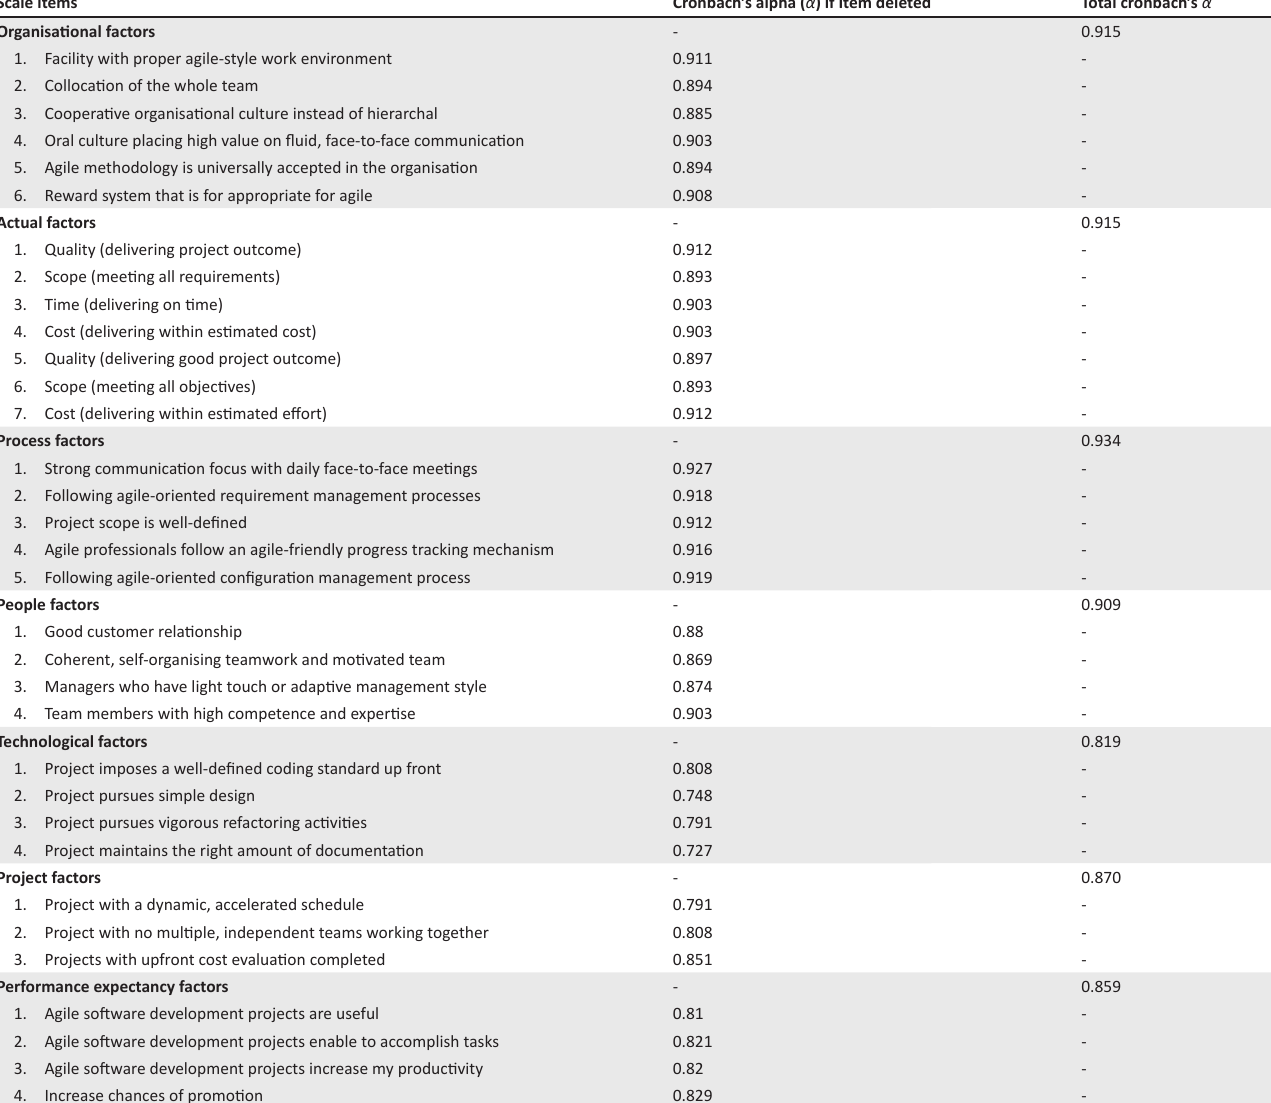
TABLE 2: Cronbach’s alpha reliability of the constructs for each data sample ( N = 460). Scale